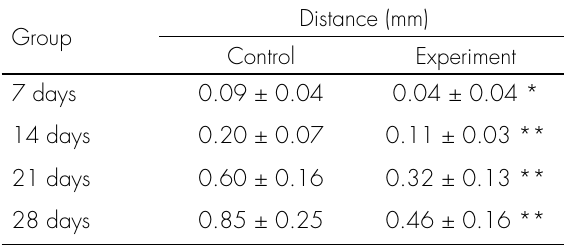
* represents p < 0.05; ** represents p <